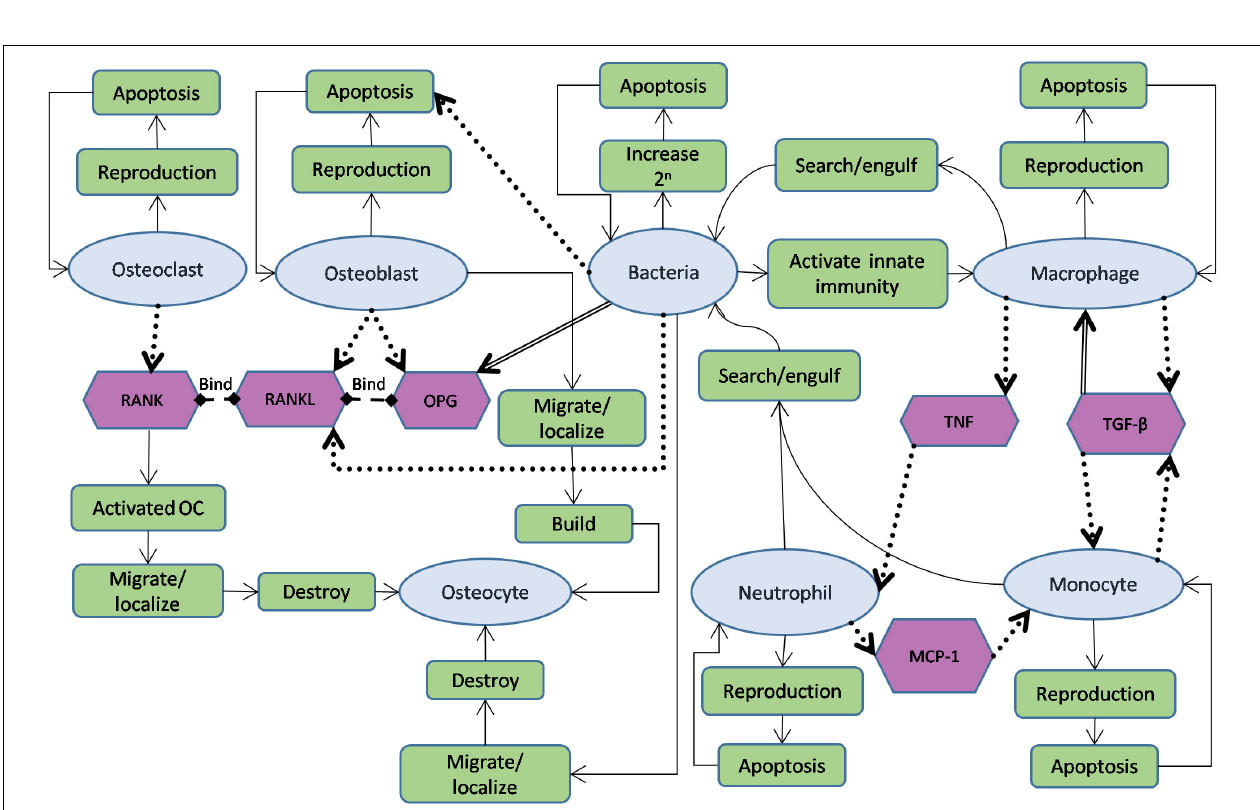
FIGURE 2 | Schematic diagram showing agents used in the model, interactions between them, and governing functions for each of them. The oval shapes represent cell agents; hexagons represent signals in the model. The rectangle boxes represent the main functions and roles of each agent. A solid arrow indicates the flow of agent functions, a dotted arrow characterizes stimulation from source to target (destination), while a double-lined arrow reflects the opposite effect (source leads to reduce the destination object).